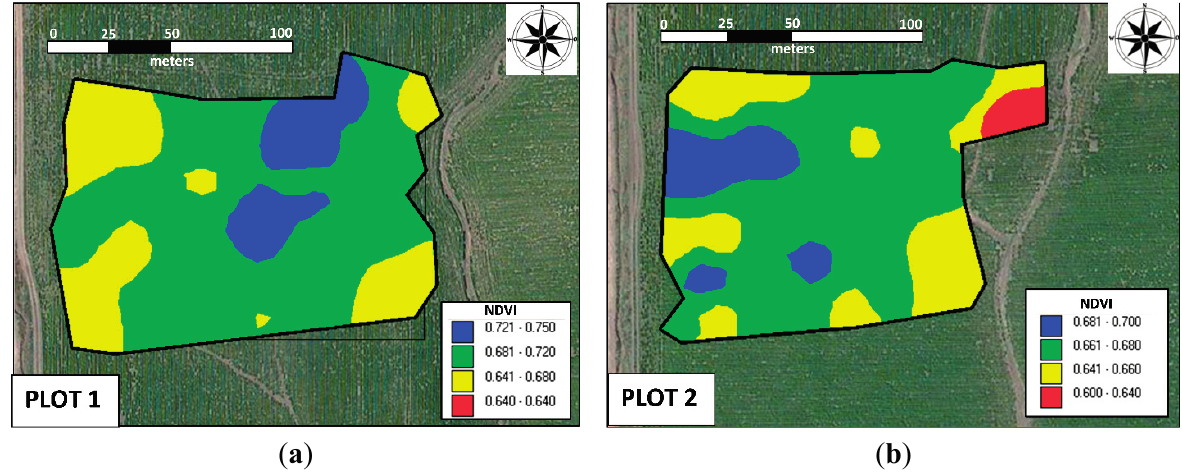
Figure 5. Spatial distribution of NDVI in both fields: ( a ) field 1 and ( b ) field